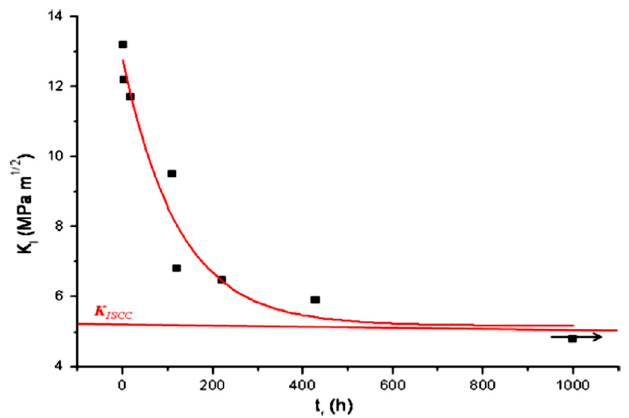
Figure 10. t f - K I plot for determination of K ISCC. Reproduced with permission from [83], Elsevier, 2012.